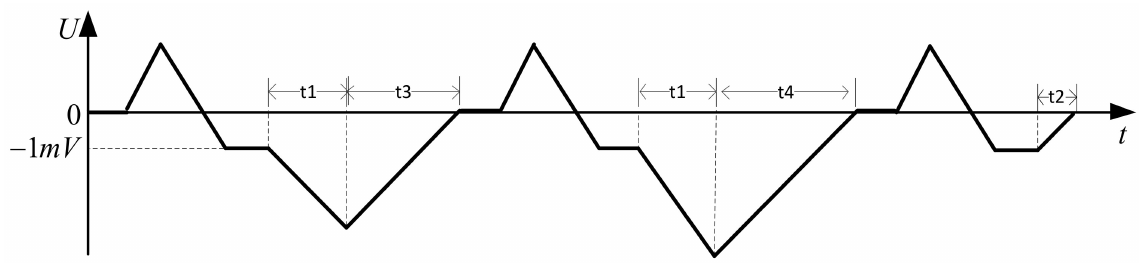
Figure 7. Voltage change curve of the U2